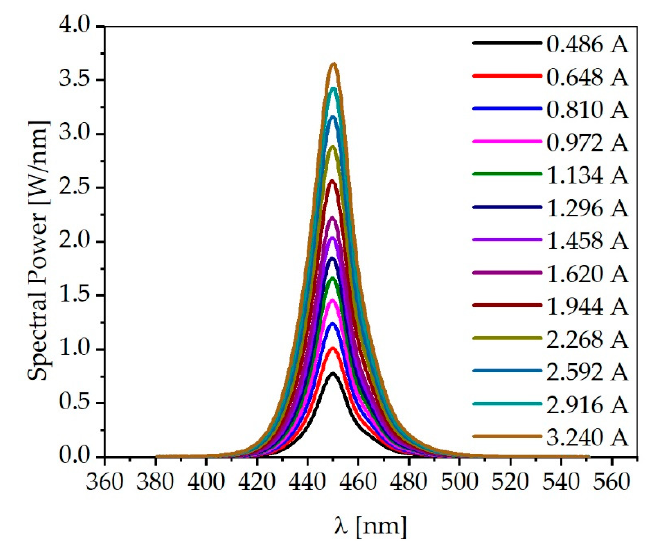
Figure 4. Spectra of the blue high-power LED used for different driving currents between 0.486 and 3.240 A.